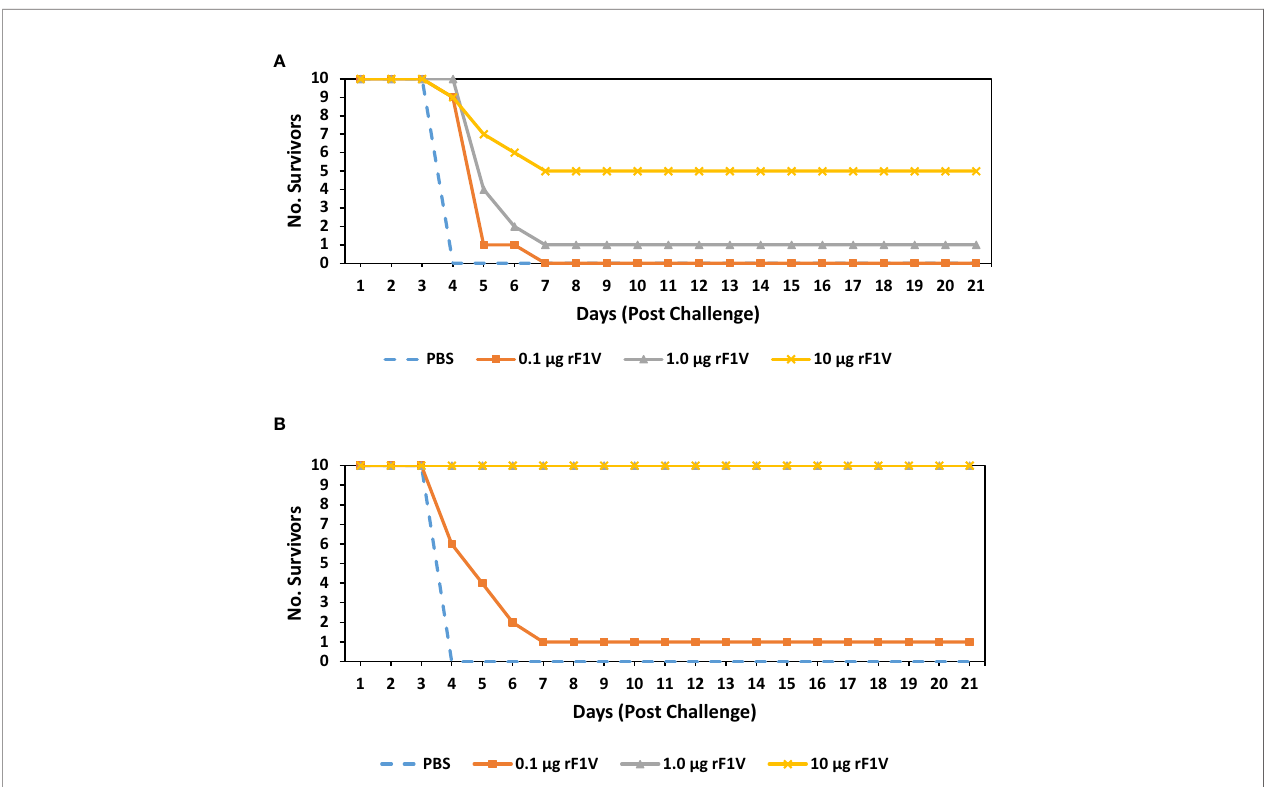
FIGURE 1 | BALB/c mice vaccinated with rF1V are more susceptible than CD1 vaccinated mice to Y. pestis infection. (A) BALB/c or (B) CD1 mice were vaccinated once, subcutaneously, with mock/PBS, 0.1 µg, 1 µg or 10 µg of rF1V (n=10). At 26 days post vaccination, BALB/c and CD1 mice were exposed to 2.02x10 6 CFU (approximately 30 LD 50 equivalents) or 1.75x10 6 CFU (approximately 53 LD 50 equivalents) of aerosolized Y. pestis CO92, respectively. Survival was monitored for 21 days post